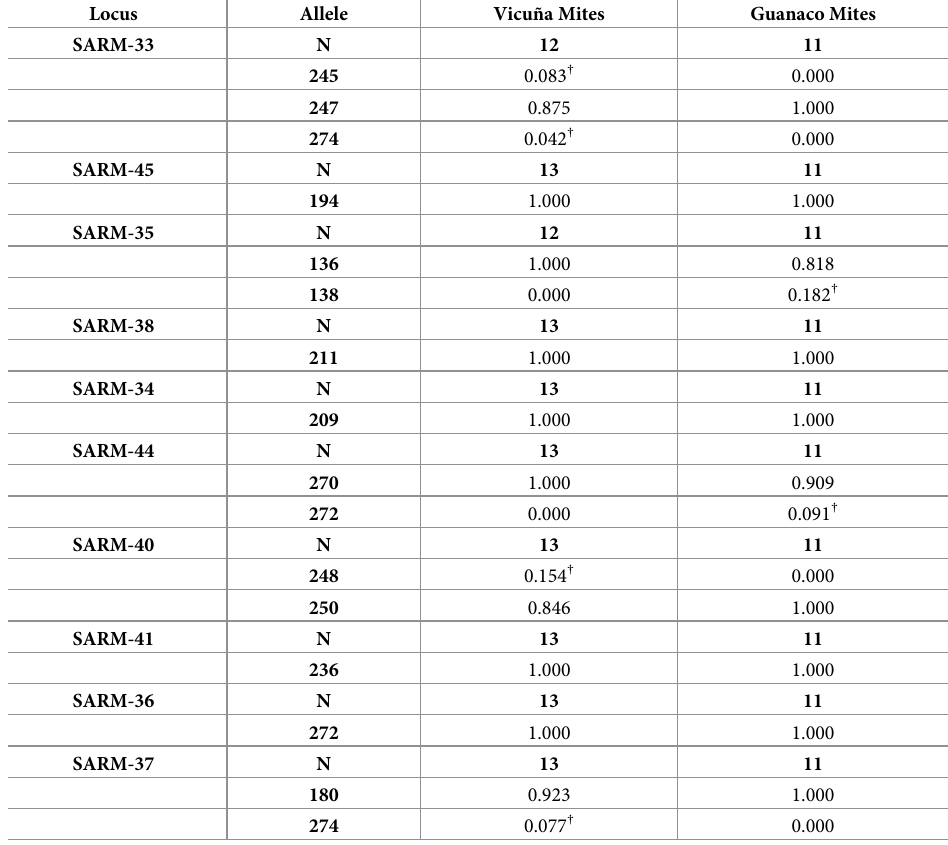
Table 3. Frequency of alleles by population.